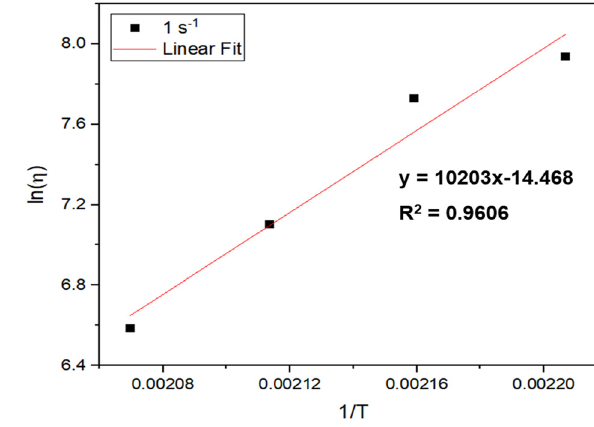
Figure 5: Plot of ln ( viscosity ) versus 1/ T for the PLA at 1/s shear rate.